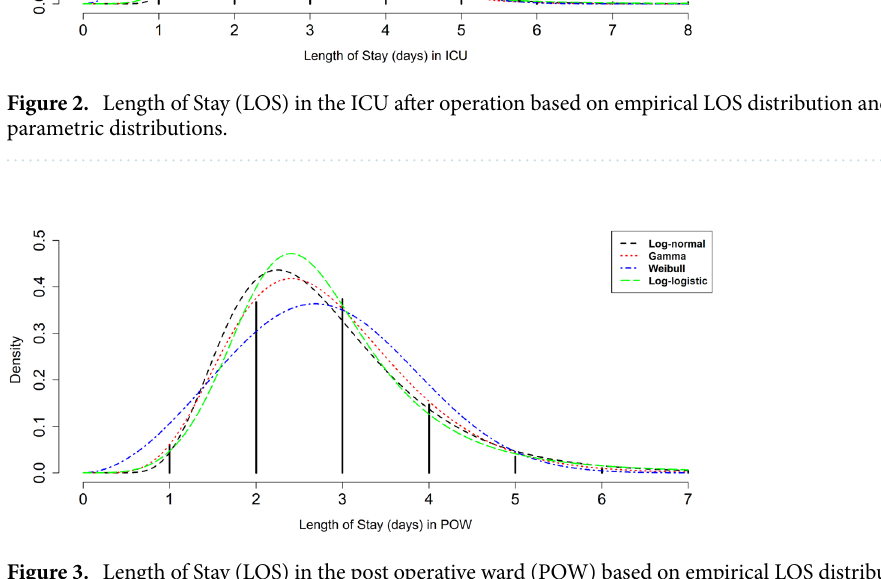
Figure 3. Length of Stay (LOS) in the post operative ward (POW) based on empirical LOS distribution and fitted parametric